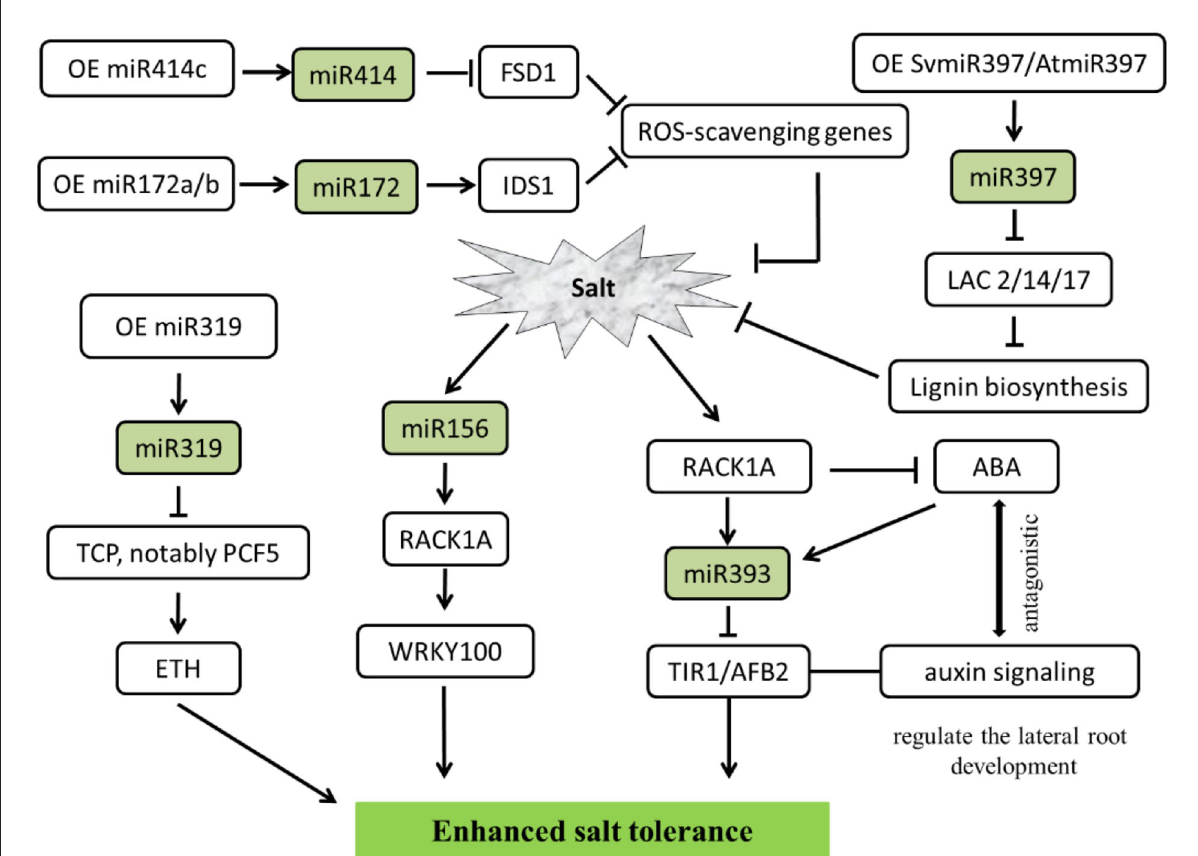
FIGURE4 MiRNA-mediated regulating network responses salt stress in plants. The arrows and hammer represent positive and negative regulation, respectively. OE, overexpression; ROS, reactive oxygen species; ETH, ethylene; ABA, abscisic acid; FSD1, iron superoxide dismutase 1; IDS1, INDETERMINATE SPIKELET 1; LAC, LACCASE enzymes; TCP/PCF, teosinte branched (tb1)-cycloidea (CYC)-proliferating cell factors1 and 2 (PCF1 and PCF2) transcription factor; RACK1A, receptor for activated C kinase 1; WRKY, WRKY transcription factors; TIR, transport inhibitor response; AFB, auxin F-box